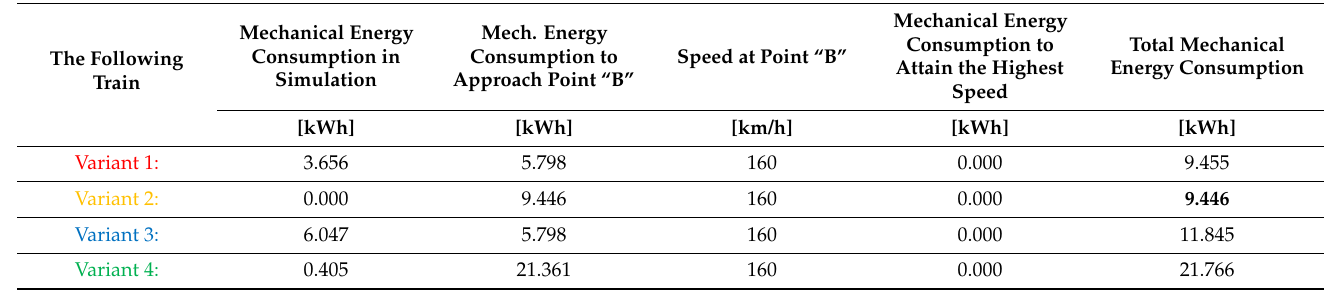
Table 5. Standardization of results for context 2.